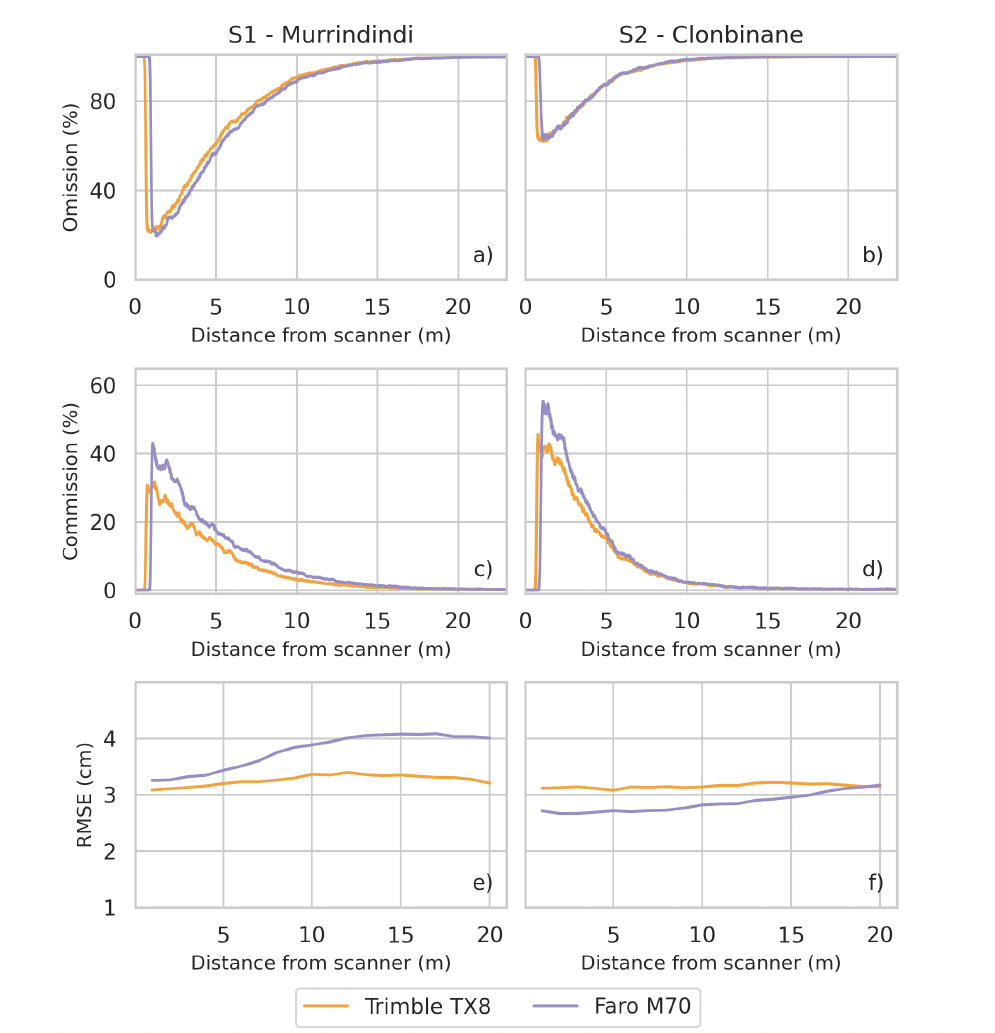
Figure 5. Effect of distance from scanner on the rate of ground observed when captured from a single scanner. Omission ( a , b ), commission ( c , d ) and RMSE ( e , f ) are shown for the single scan data in comparison to the merged scan voxel